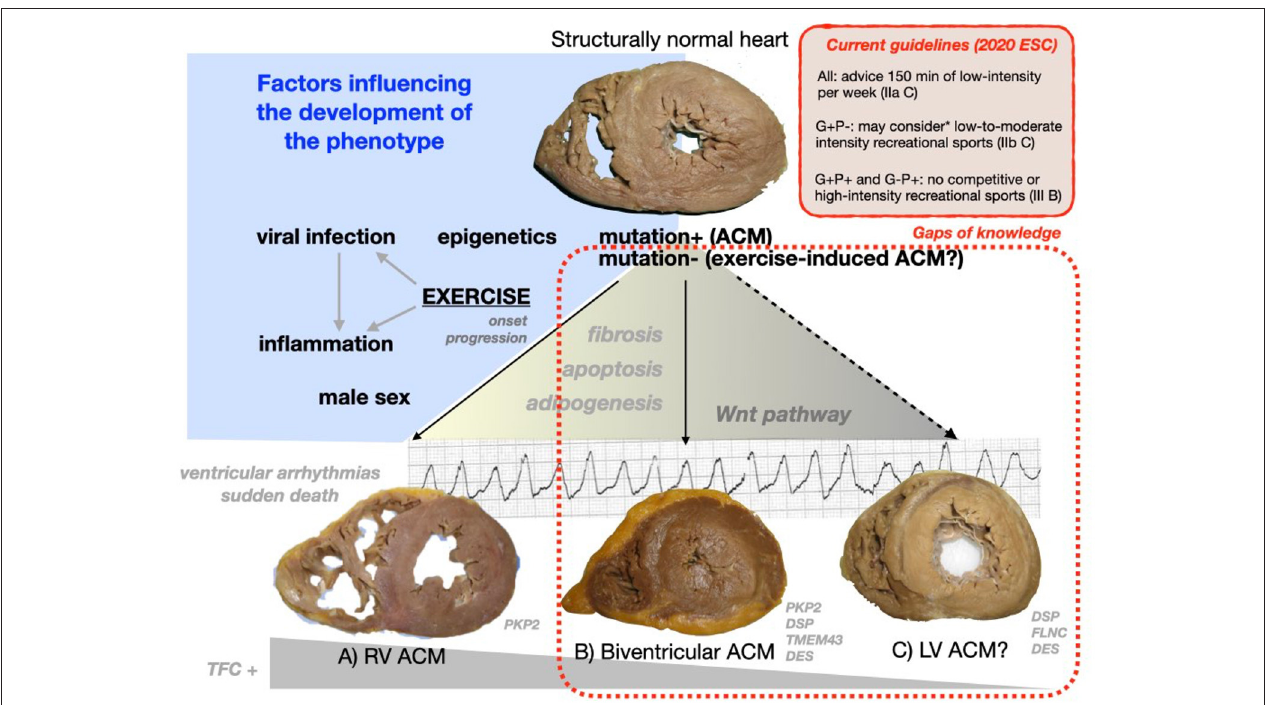
FIGURE 5 | Central figure. The progression of a structurally normal heart harboring a mutation or without any genetic hit to an ACM phenotype involving just the right ventricle (A) , both ventricles (B) or the left ventricle in isolation (C) . (A–C) Were obtained at autopsies of patients with ACM and sports-triggered sudden cardiac death. Different factors may modulate this transition yielding structural and arrhythmic features through the Wnt pathway dysregulation (as presented in Table 3 ). The rate of patients fulfilling TFC 2010 and the specific mutated genes underlying may widely differ among ACM phenotypes A–C. The most important genotype–phenotype associations based on the authors clinical and forensic experience are shown at the bottom of this figure (further information on this topic is provided in Table 1 ). *Only applicable to low risk patients with no history of cardiac arrest/ventricular arrhythmias, unexplained syncope, minimal structural cardiac abnormalities, < 500 PVCs/24h, and no evidence of exercise-induced complex ventricular arrhythmias (11). ACM, arrhythmogenic cardiomyopathy; ESC, European Society of Cardiology; G, genotype; P, phenotype; TFC, Task Force Criteria 2010; LV, left ventricular; RV, right ventricular; PKP2, plakophillin-2; DSP, desmoplakin; DSG2, desmoglein-2; DES, desmin; TMEM43, transmembrane protein 43; FLNC, filamin C; PVCs, premature ventricular